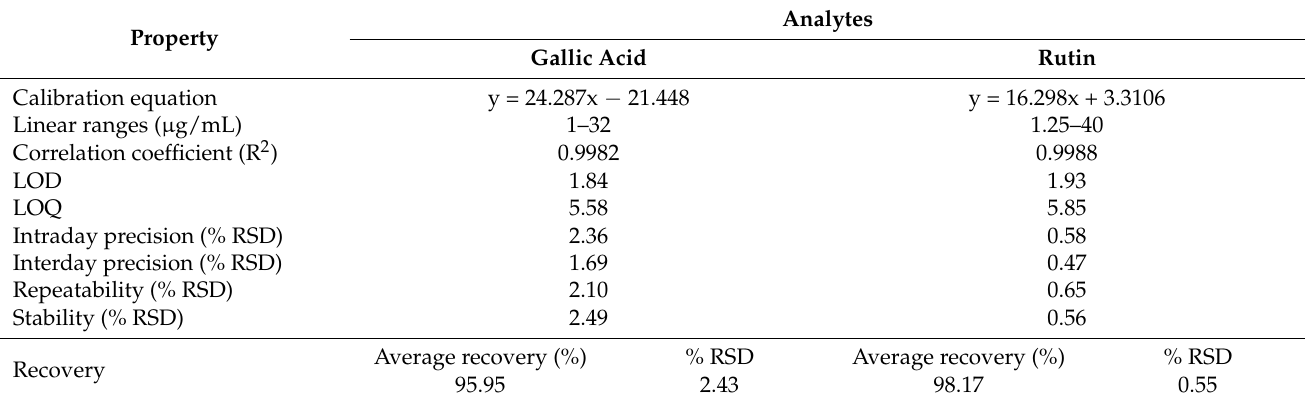
Table 1. Method validation for two compounds